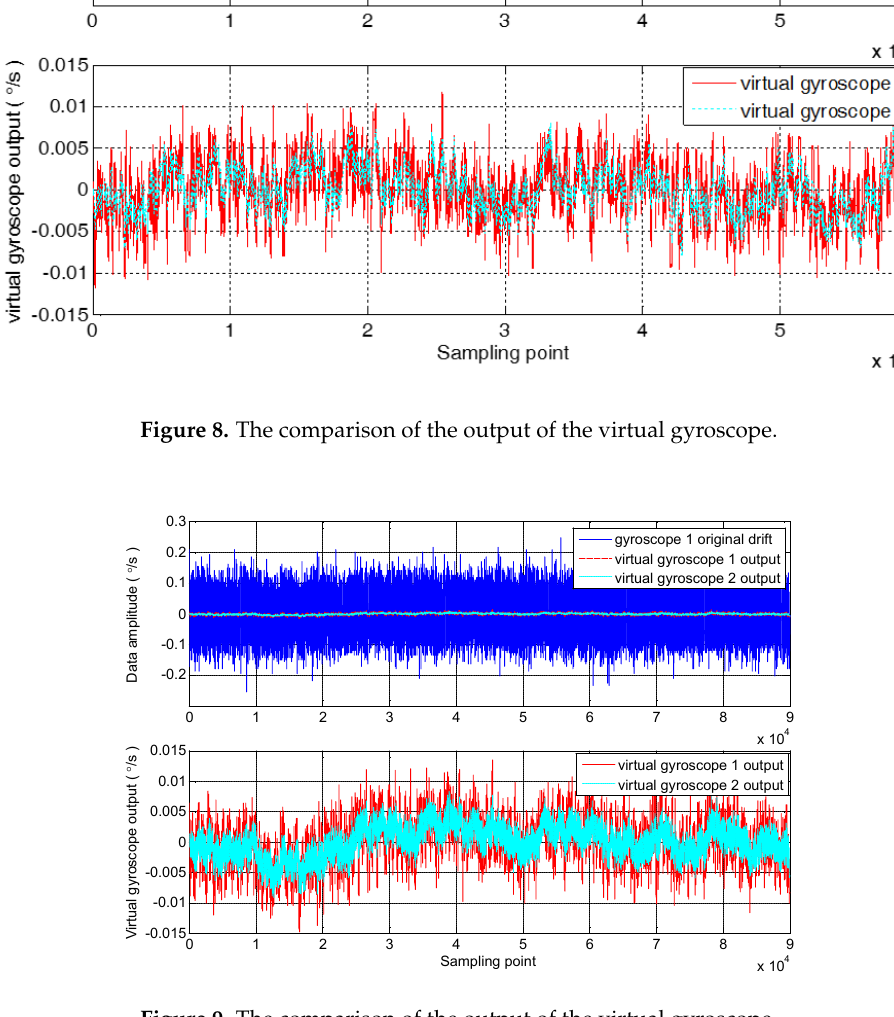
Figure 9. The comparison of the output of the virtual gyroscope.